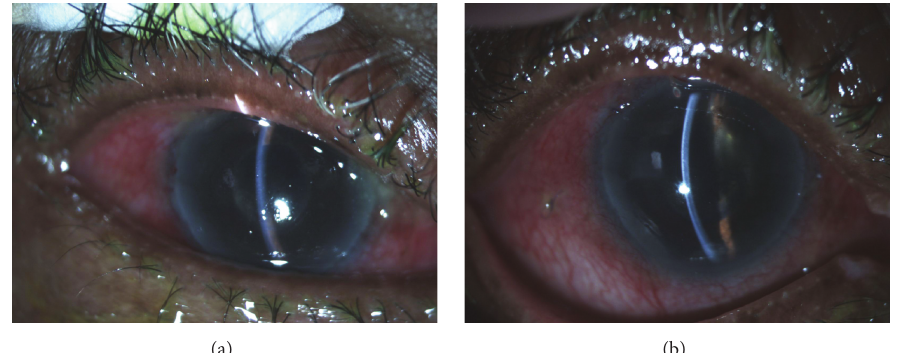
Figure 2: Malignant glaucoma treatment. (a) The patient presented after glaucoma filtration surgery with a shallow chamber and markedly elevated intraocular pressure, not responding to initial treatment with cycloplegia and laser. (b) After pars plana vitrectomy, the anterior chamber was deep and the intraocular pressure was